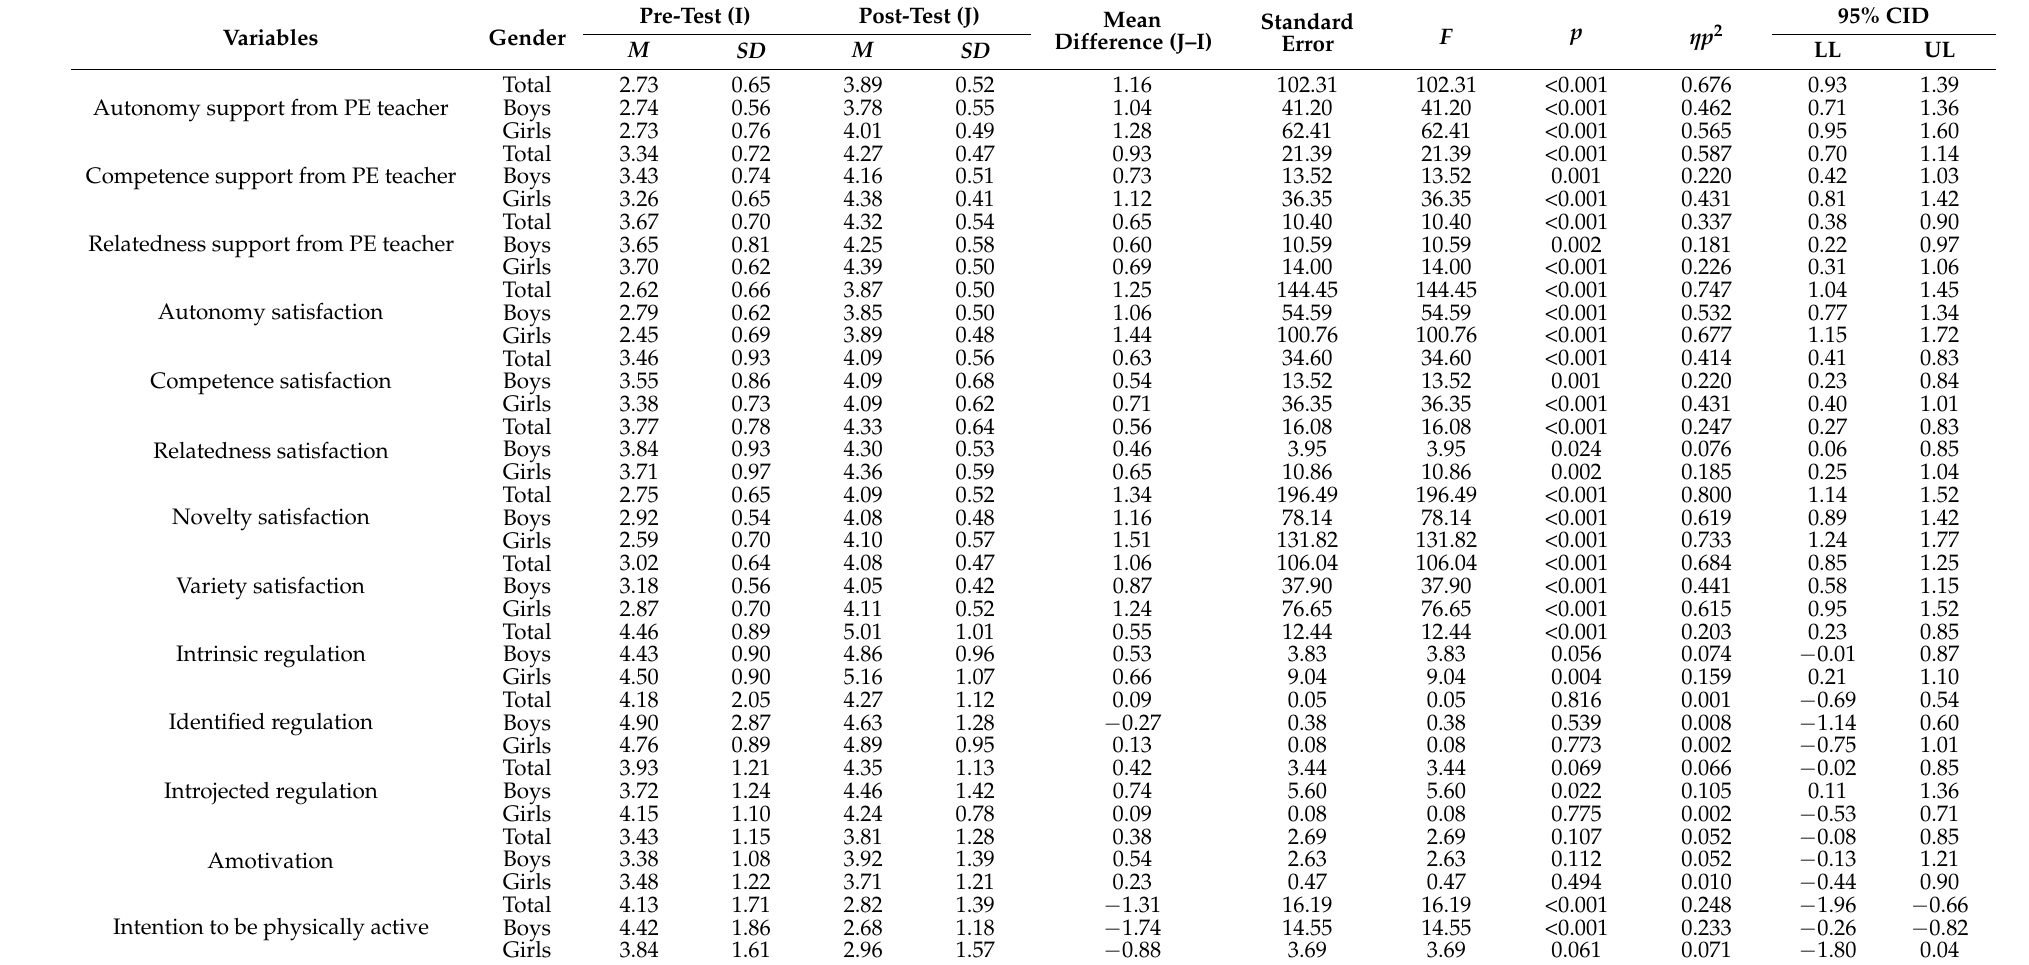
Table 5. Descriptive statistics and intervention effects on motivational